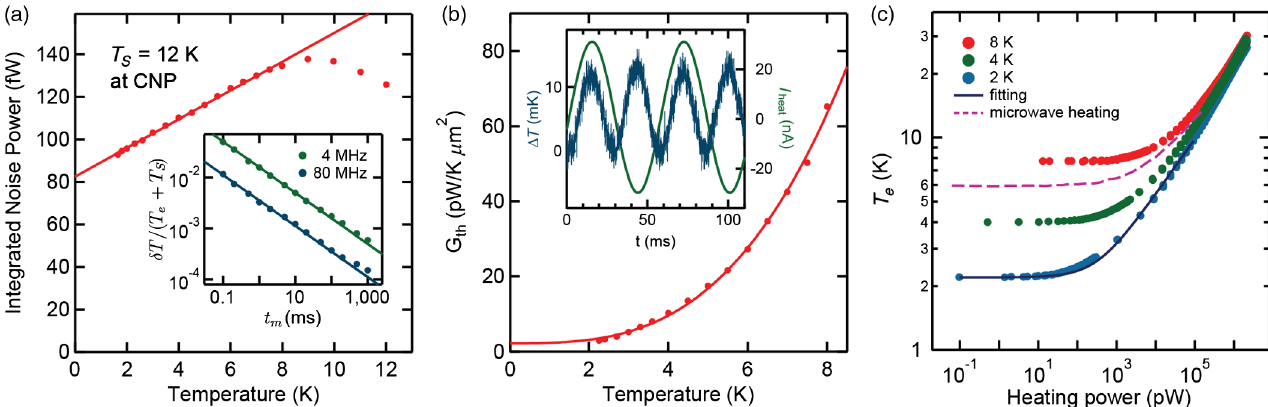
FIG. 2. (a) The integrated noise power versus refrigerator temperature, demonstrating the expected temperature dependence of the Johnson-noise signal. The deviation at temperatures above 8 K are due to the temperature dependence of the NbTiN inductor. The inset shows the precision of the noise thermometry taken with two measurement bandwidths, 4 and 80 MHz, versus integration time. A resolution of 100 ppm is achieved, in agreement with the Dicke radiometer formula (shown as lines). (b) The results of the differential thermal-conductance measurements. The inset shows a time trace, taken at 4 K, of the small heating current at 17.6 Hz, and the resulting 12-mK temperature oscillations at 35.2 Hz detected with the noise thermometer. The red curve is a power-law fit with exponent 2 : 7 (cid:9) 0 : 3 . (c) The results of applying large dc heating currents at various sample temperatures, T p (points). The expected form is shown as the blue line. Also shown is the heating of the electron gas versus applied microwave power at 1.161 GHz, also showing a similar heating curve and demonstrating the microwave bolometric effect with